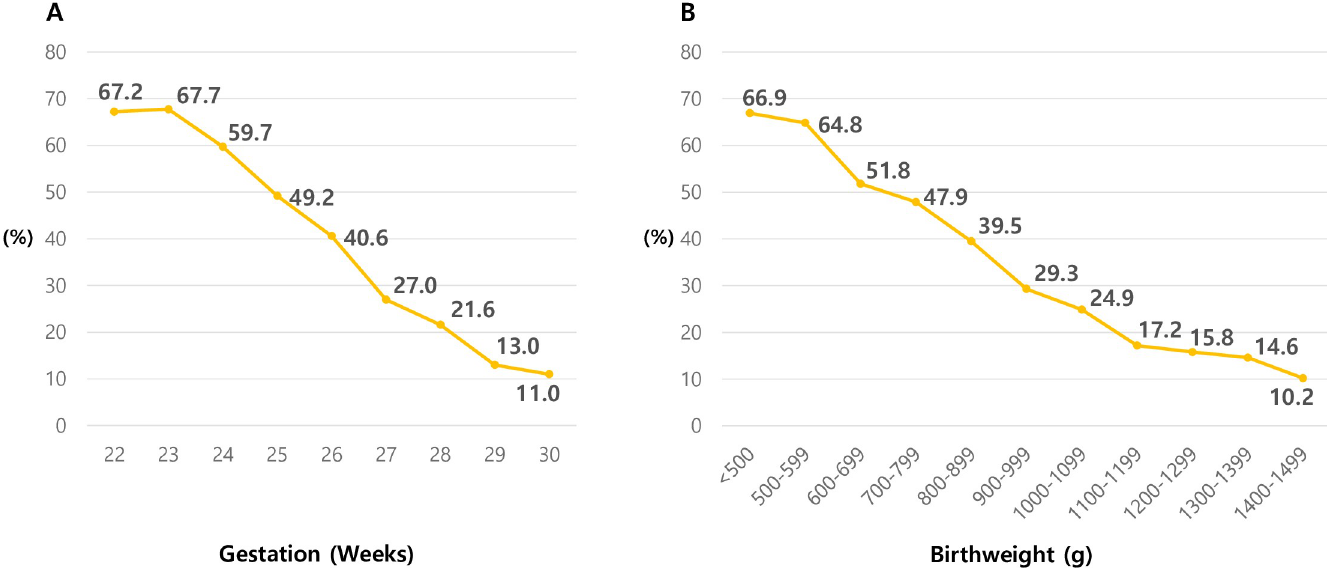
Fig 3. Changes in the proportion of treated hypotension in VLBW infants during the first postnatal week. (A) Changes according to gestation. (B) Changes according to birth